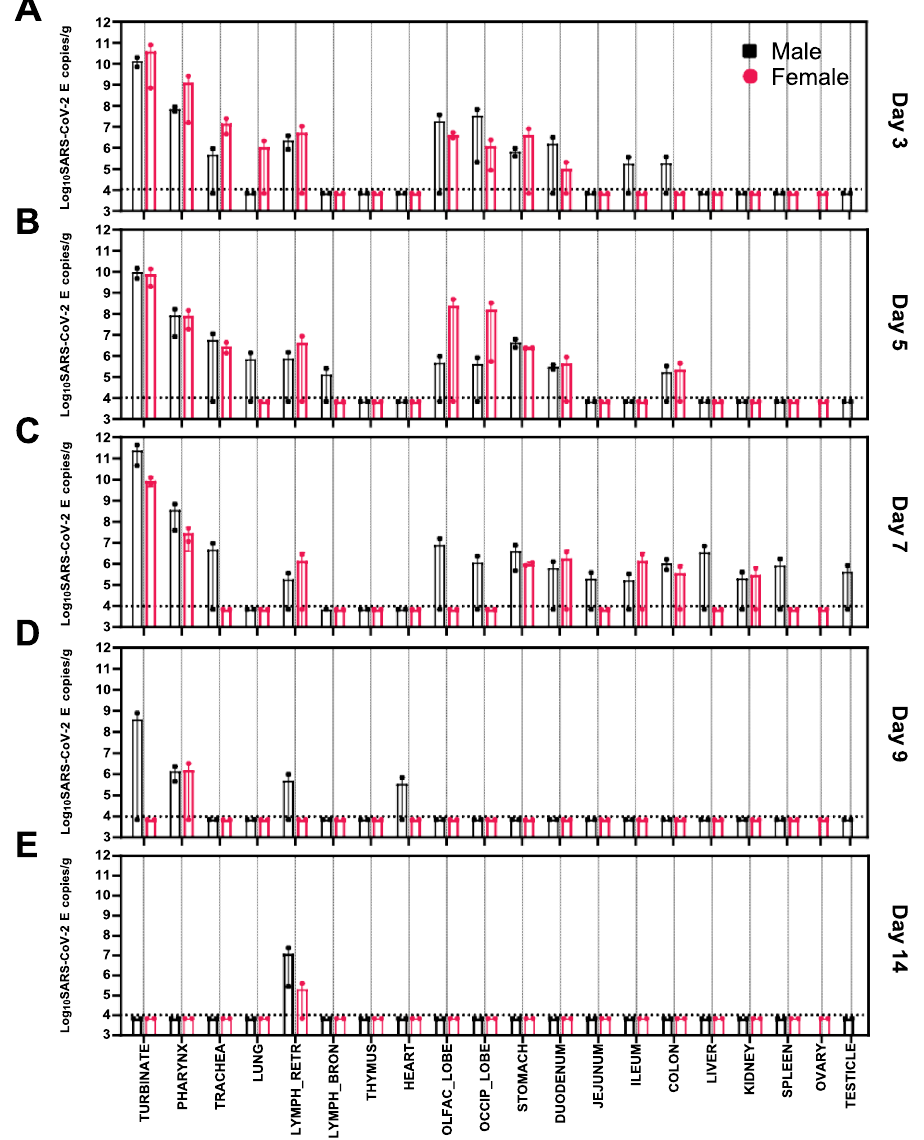
Figure 3. Distribution of SARS-CoV-2 RNA in ferret tissues and organs after intranasal challenge. Log 10 SARS- CoV-2 viral genomes per gram of tissue detected in organs or tissues of ferrets inoculated with SARS-CoV-2 Australia/VIC01 isolate. Panel ( A ) shows data from two male and two female ferrets euthanased on day 3, ( B ) day 5, ( C ) Day 7, ( D ) day 9, and ( E ) day 14 respectively. Bars indicate mean values, together with individual data points shown as black squares for males and rose-coloured circles for female ferrets, error bars indicate ± SEM. The horizontal dashed line shows the lower limit of detection. LYMPH RETR represents the retropharyngeal lymph node, LYMPH BRON the bronchial lymph node, OLFAC LOBE the olfactory bulb, and OCCIP LOBE the occipital lobe